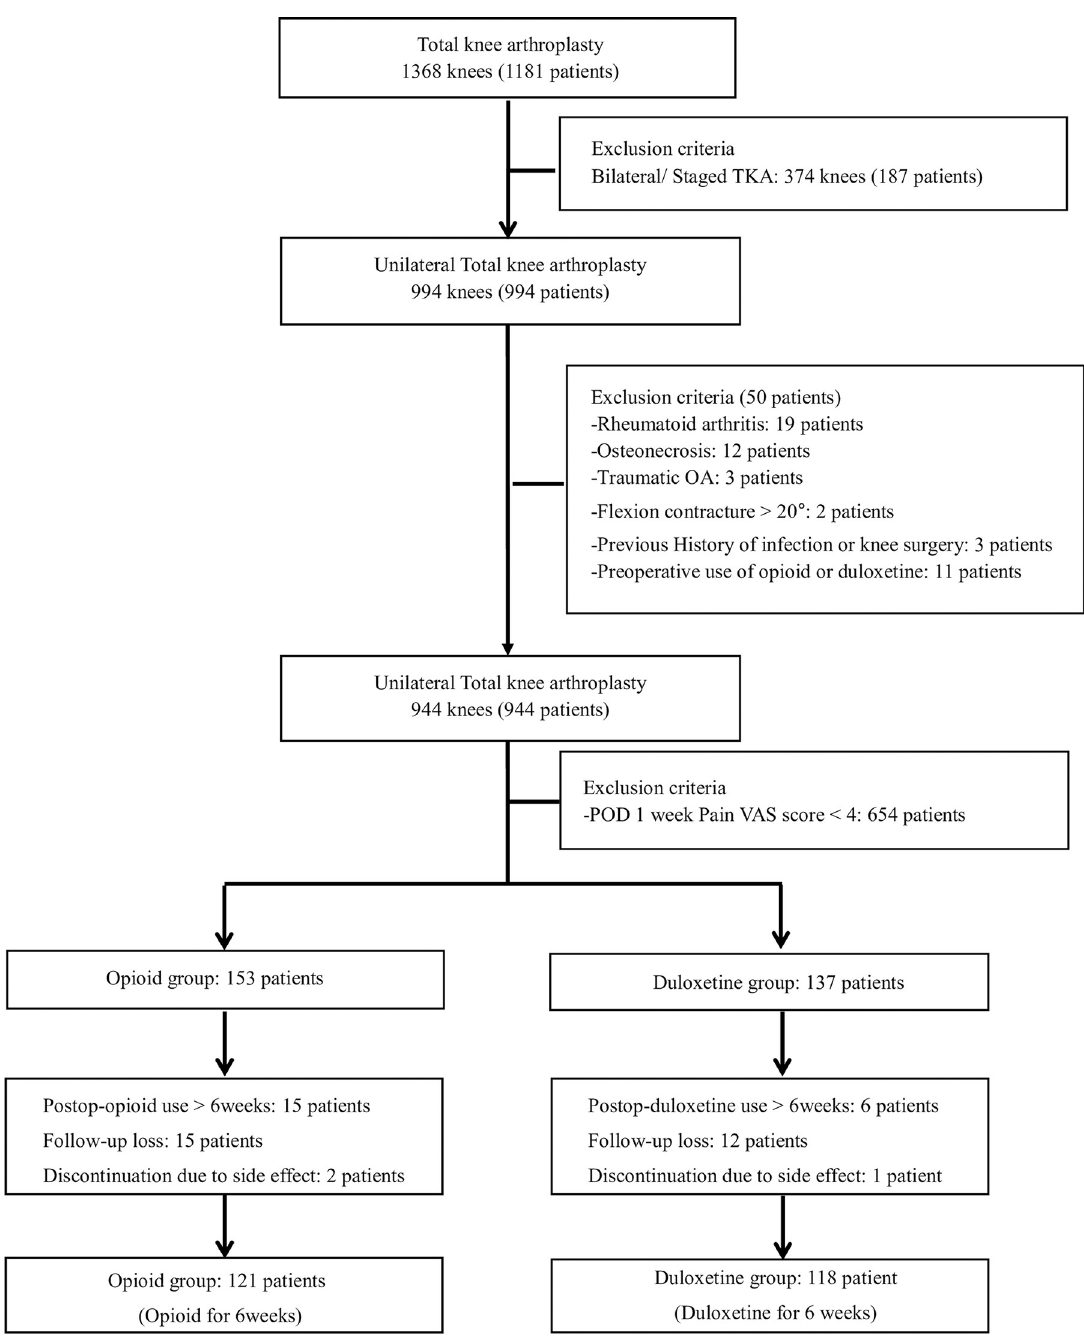
Fig 1. Flow chart describing patients invited to participate in this study and included in the final